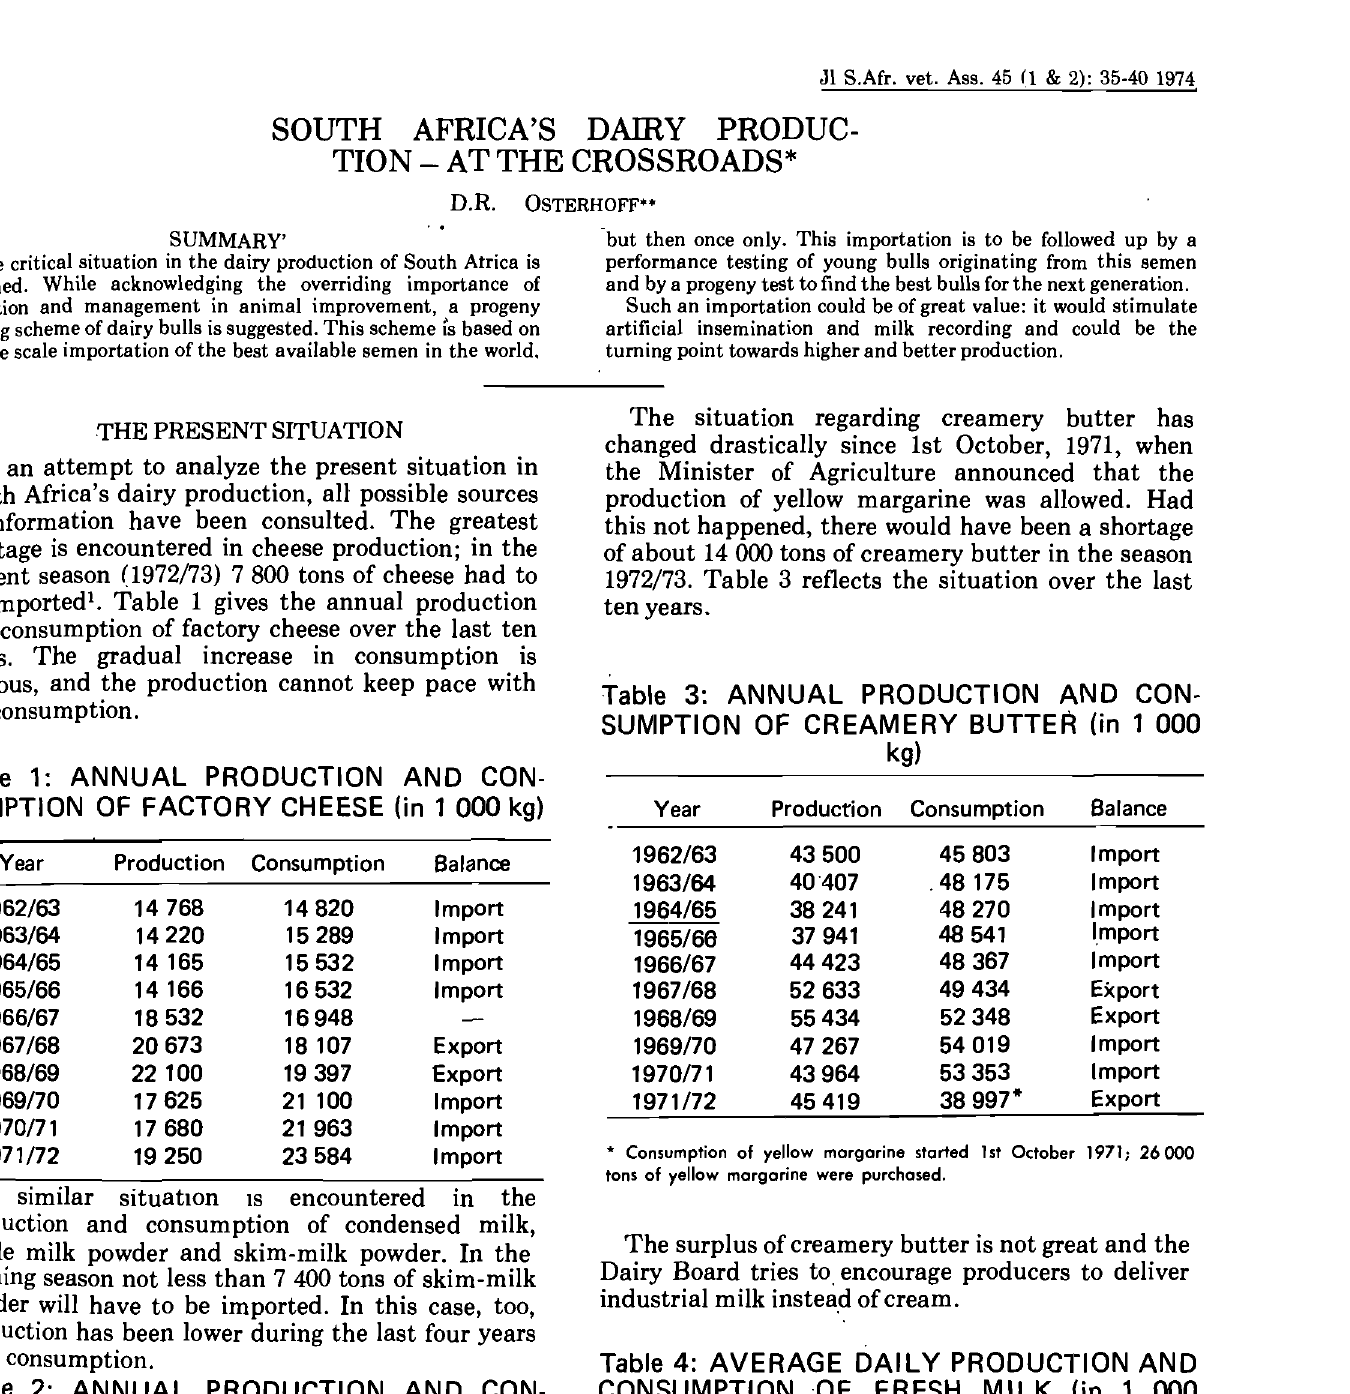
Table 2: ANNUAL PRODUCTION AND CON SUMPTION OF CONDENSED MILK, WHOLE MILK POWDER AND SKIM-MILK POWDER (in